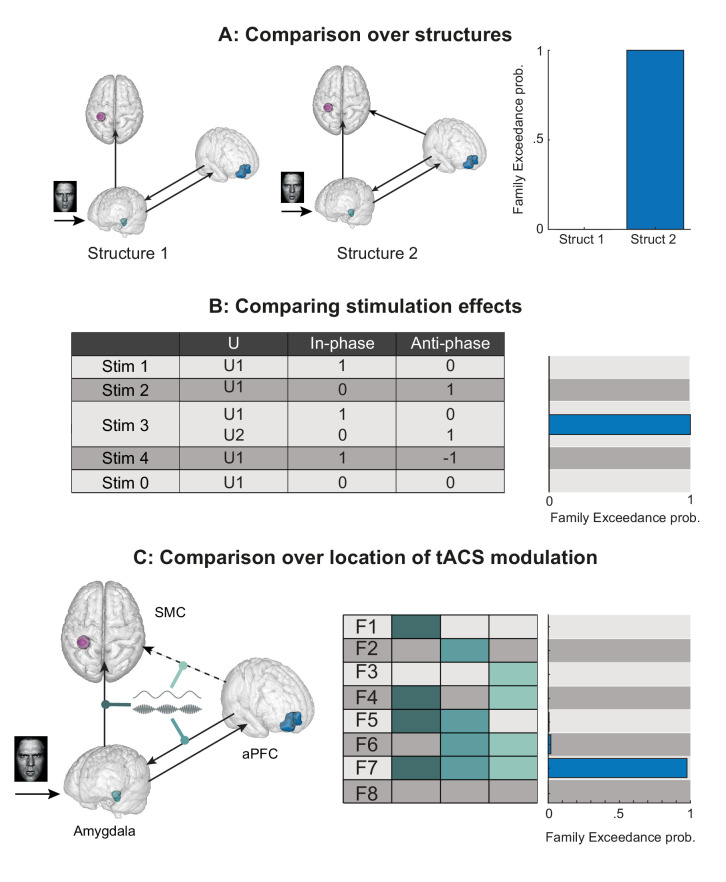
Comparing models of tACS modulation.(A) Comparison over structure families. Structure one does not contain a direct connection between aPFC and SMC, tACS modulation of aPFC→ SMC connectivity is therefore forced through the amygdala. Structure two does contain a direct connection. Model comparison shows that structure two is more likely, suggesting that not all modulation of aPFC→ SMC is gated by the amygdala. (B) Comparison over stimulation effects. There were five ways in which the tACS manipulation could modulate connectivity in our models. ‘Stim 1’ and 'Stim 2' model effects of either in-phase or anti-phase effects, respectively. ‘Stim 3’ models in- and anti-phase effects to modulate connectivity independently of one another. ‘Stim 4’ models in-phase and anti-phase as being opposite in sign but similar in amplitude. ‘Stim 5’ models no effect of stimulation in either condition. The data is best described by Stim 3, showing independent effects of both stimulation conditions on connectivity. (C) Comparison over stimulation locations. tACS was allowed to modulate three different connections; (i) connection from aPFC → amygdala, (ii) connection from amygdala → SMC and (iii) connection from aPFC → SMC. We also included models having two, or all connections modulated by tACS. Model comparison shows that all three connections are influenced by tACS, suggesting network wide effects of stimulation. Only parameters extracted from aPFC→SMC connections predicted behavioral effects.